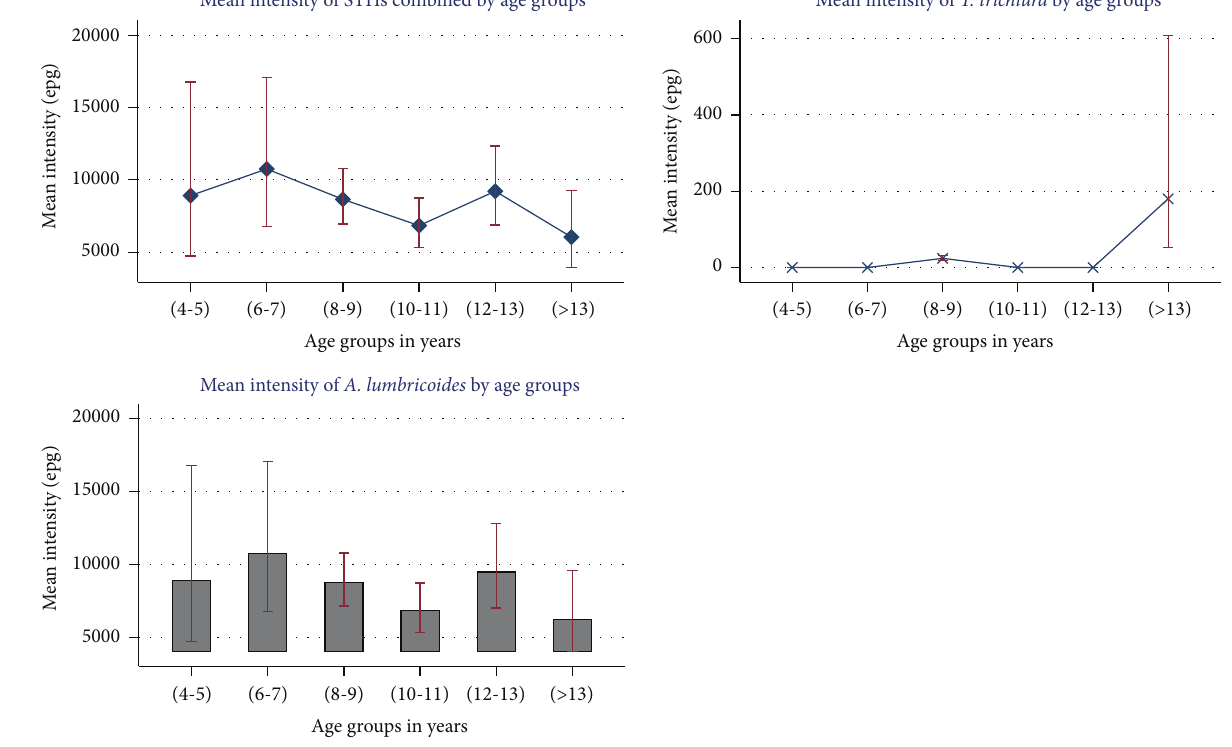
Figure 3: Mean intensity (epg) of various STHs species by age